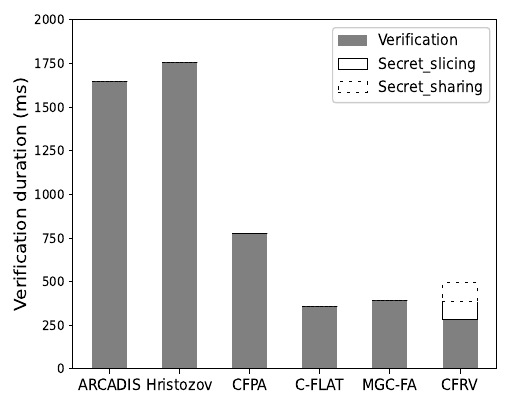
Figure 12. Ten-round